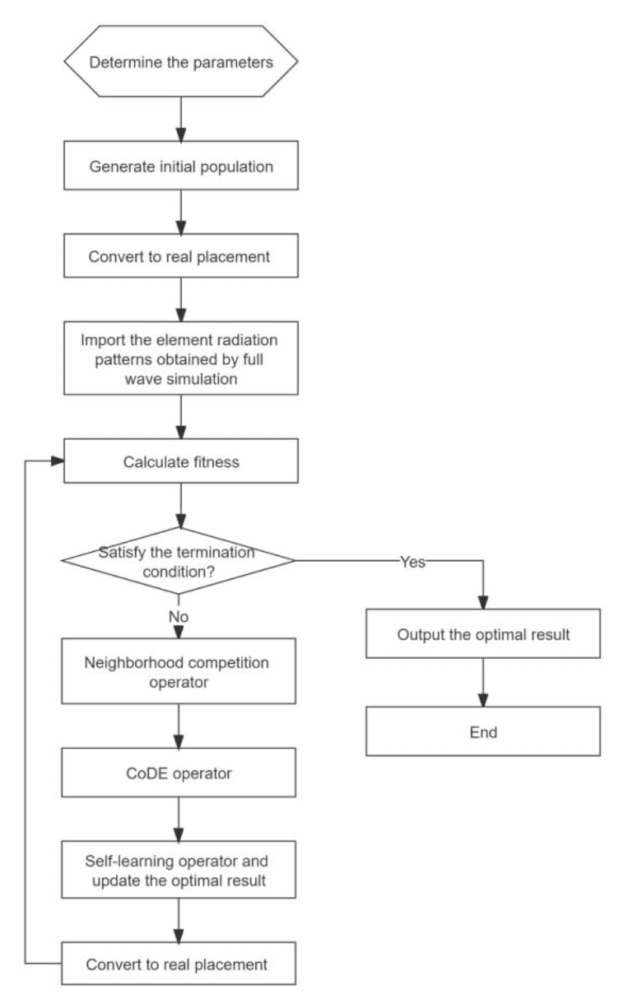
Figure 2. The flow chart of antenna array placement optimization using the MCDE